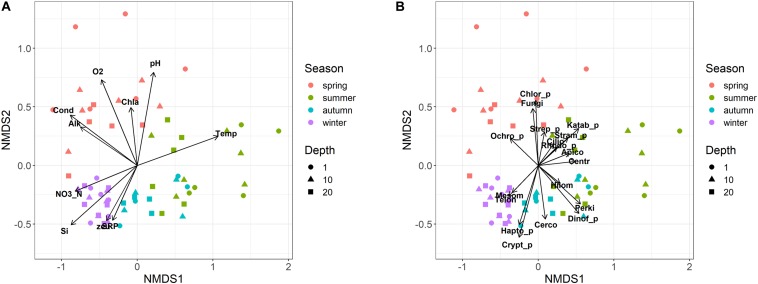
Non-metric multidimensional scaling (NMDS) ordination (stress = 0.15) of samples based on the microeukaryotic composition (ASVs). Samples are coded by season (colors) and depth (symbols). (A) vector fitting of significant (P < 0.01) environmental variables: Temp, water temperature; Cond, water conductivity; O2, dissolved oxygen; SRP, soluble reactive phosphorus; NO3_N, nitrate nitrogen; Si, reactive silica; Alk, alkalinity; zeu, euphotic depth; Chla, Chlorophyll-a. (B) Vector fitting (at least P < 0.1) of microeukaryotic divisions: Apico, Apicomplexa; Centr, Centroheliozoa; Cerco, Cercozoa; Chlor_p, Chlorophyta; Cilio, Ciliophora; Crypt_p, Cryptophyta; Dinof_p, Dinoflagellata; Fungi, Fungi; Hapto_p, Haptophyta; Hilom, Hilomonadea; Katab_p, Katablepharidophyta; Mesom, Mesomycetozoa; Ochro_p, Ochrophyta; Perki, Perkinsea; Rhodo_p, Rhodophyta; Stram_p, Stramenopiles_X; Strep_p, Streptophyta (Zygnemophyceae); Telon, Telonemia. The suffix “_p” indicates divisions totally or partly attributable to “phytoplankton.”